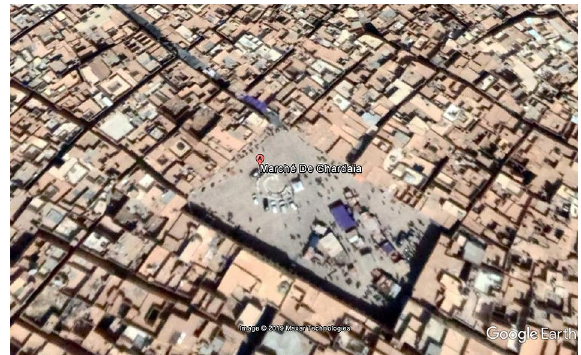
Fig. 2. The market place of Ghardaïa.